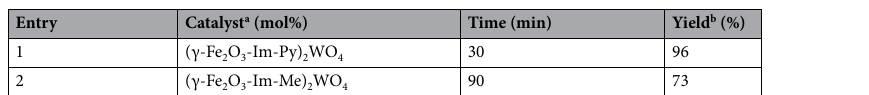
Table 9. The effect of different catalysts in the synthesis of 2-amino-3-cyano-4 H -chromene from benzyl alcohol. a Amount of the catalyst is based on W content and relative to benzyl alcohol. b Reaction conditions: 2-benzylidenemalononitrile (1 mmol), dimedone (1 mmol), catalyst (5 mol%, 142 mg), neat, 90 °C.